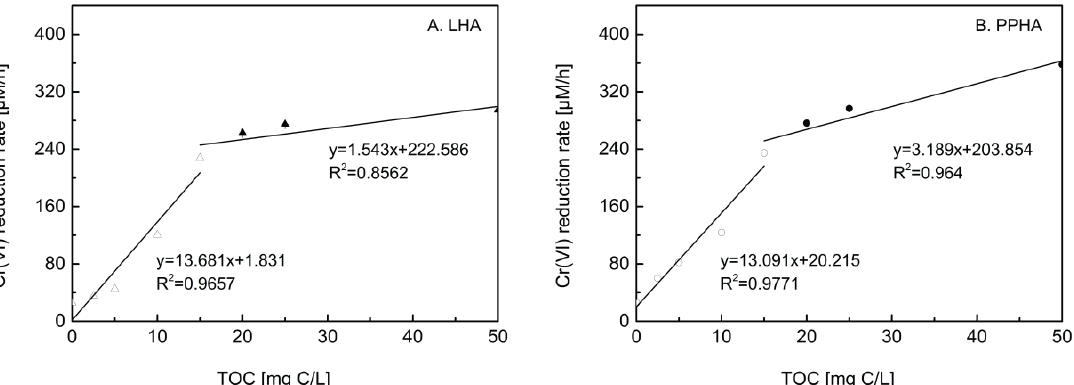
Figure 2. The relationship between TOC concentrations and rates of Cr(VI) reduction was fitted by a linear fitting slope K during different ranges of TOC concentrations. ( A ) LHA ( △ \ ▲ ) ; ( B ) PPHA ( ○ \ ● ). Hollow icons ( △ \ ○ ) represent low TOC concentrations of 2.5 - 15 mg C/L and solid icons ( ▲ \ ● ) represent high TOC concentrations of 20 - 50 mg C/L.